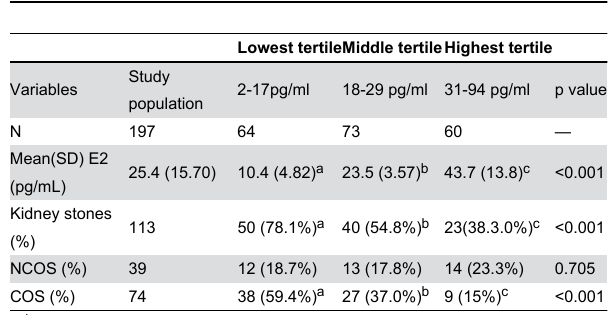
Table 4. Characteristics of the study population (n =197) per tertile of estradiol.